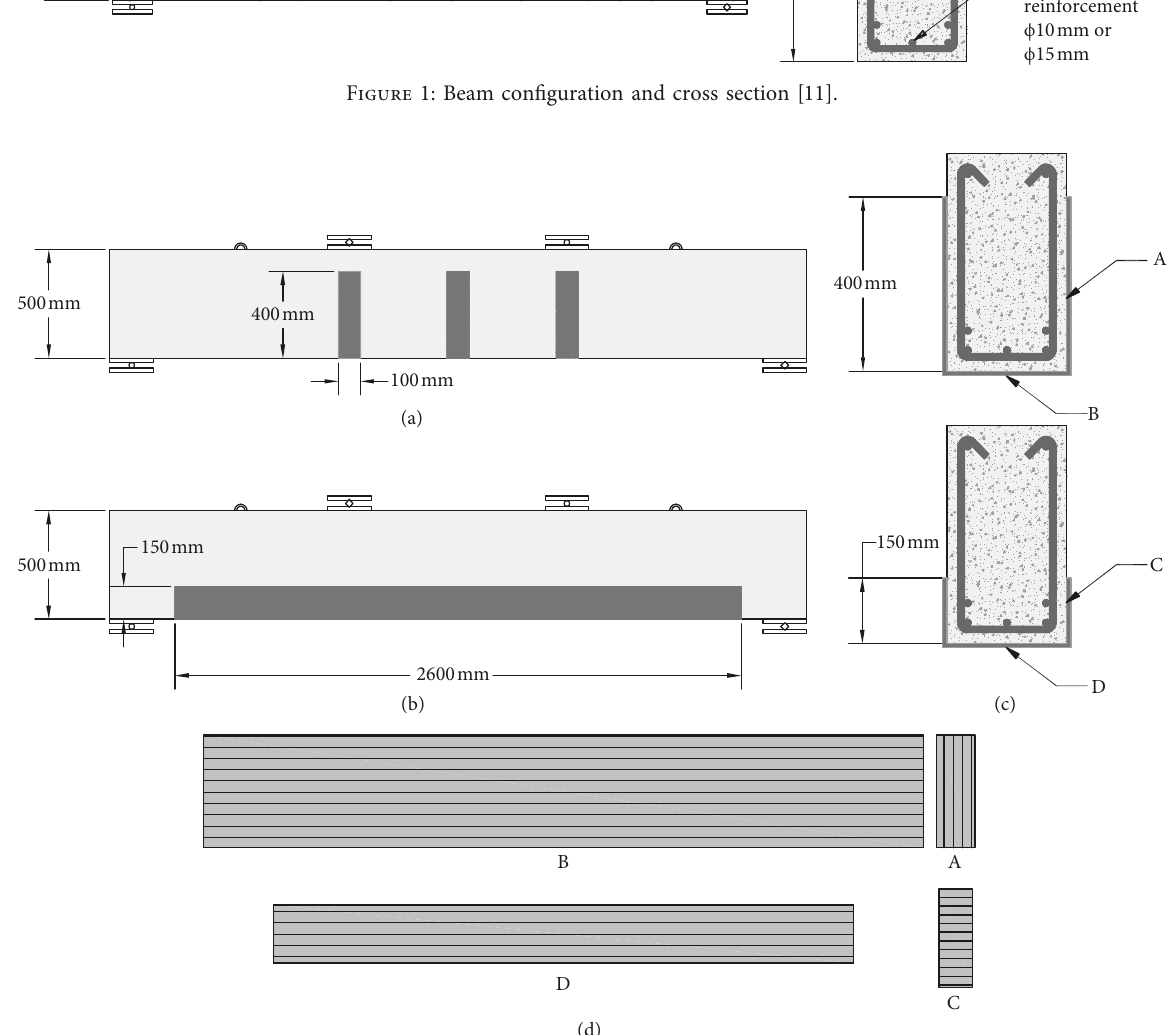
Figure 2: Wrapping techniques and sections: (a) midspan scheme, (b) bottom scheme, and (c) sections and (d) directions of BFRP along the beam axis for A, B, C, and D